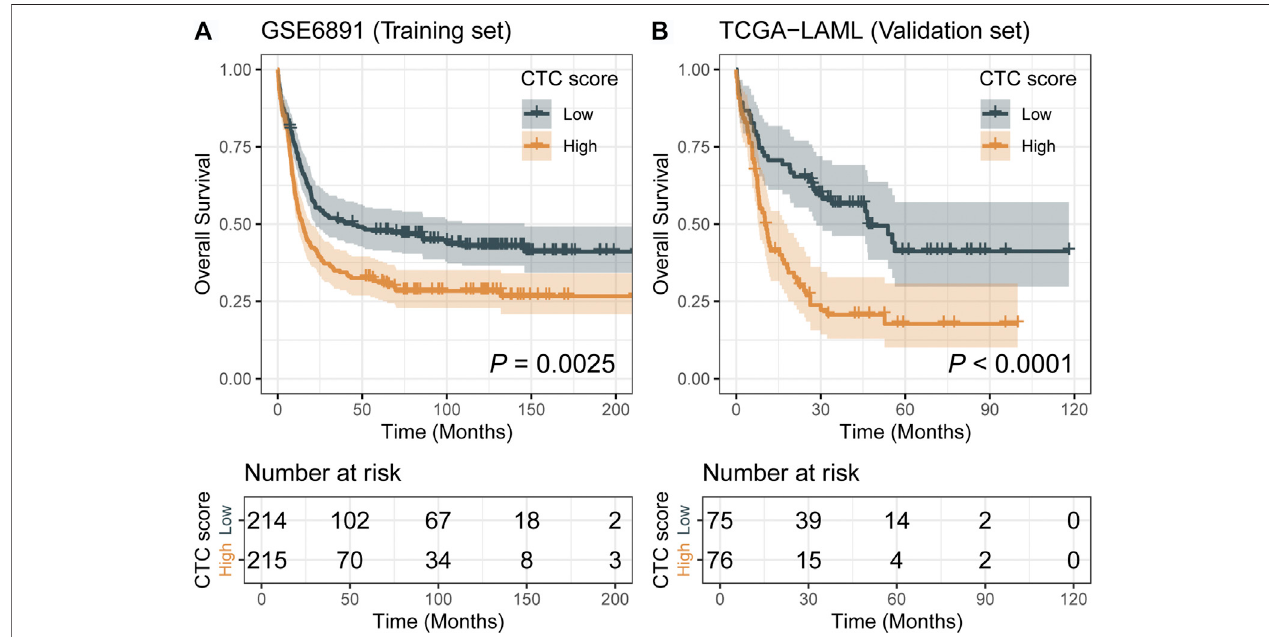
FIGURE 2 | Kaplan – Meier curves of low-cell type composition (CTC)-score and high-CTC-score groups for the training set GSE6891 (A) and the validation set TCGA-LAML (B) .